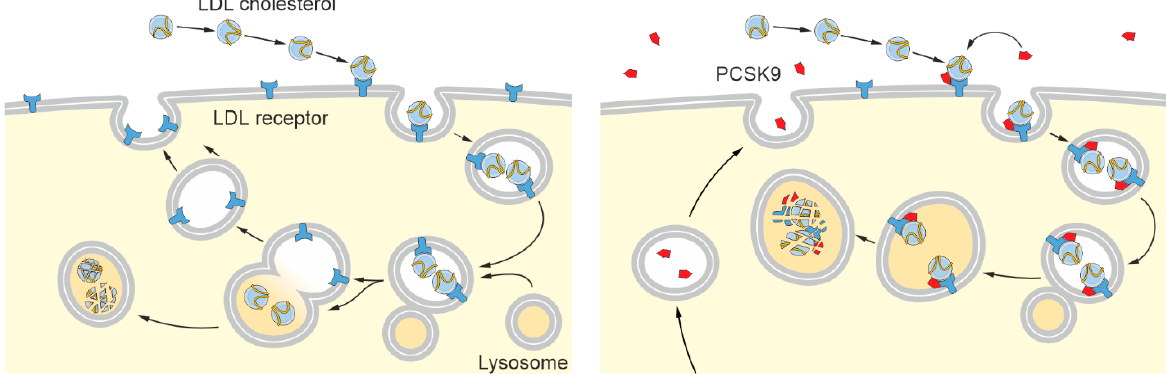
Figure 1. Mechanism of extracellular PCSK9 regulation to downregulate cell surface receptor levels. Left panel: Members of the low-density lipoprotein (LDL) receptor family bind to ligands (e.g., LDL receptors to LDL cholesterol) in the extracellular space. Clathrin-mediated endocytosis translocates the receptor/ligand complex into endosomes, where acidification causes the receptor and ligand to dissociate. The free receptor can be recycled back to the cell surface while the ligand remains in the endosomal/lysosomal degradation pathway. Right panel: Extracellular proprotein convertase subtilisin/kexin type 9 (PCSK9) is capable of binding to several members of the LDL receptor family, including its eponym, at the cell surface. After internalization, the binding strength of PCSK9 to the receptor increases at a slightly acidic pH, trapping the receptor in the intracellular compartment and leading to its lysosomal degradation and reduced cell surface receptor levels.